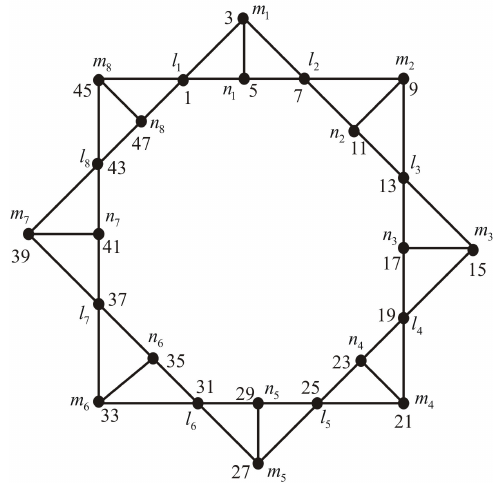
Figure 8: DSF n and its odd prime